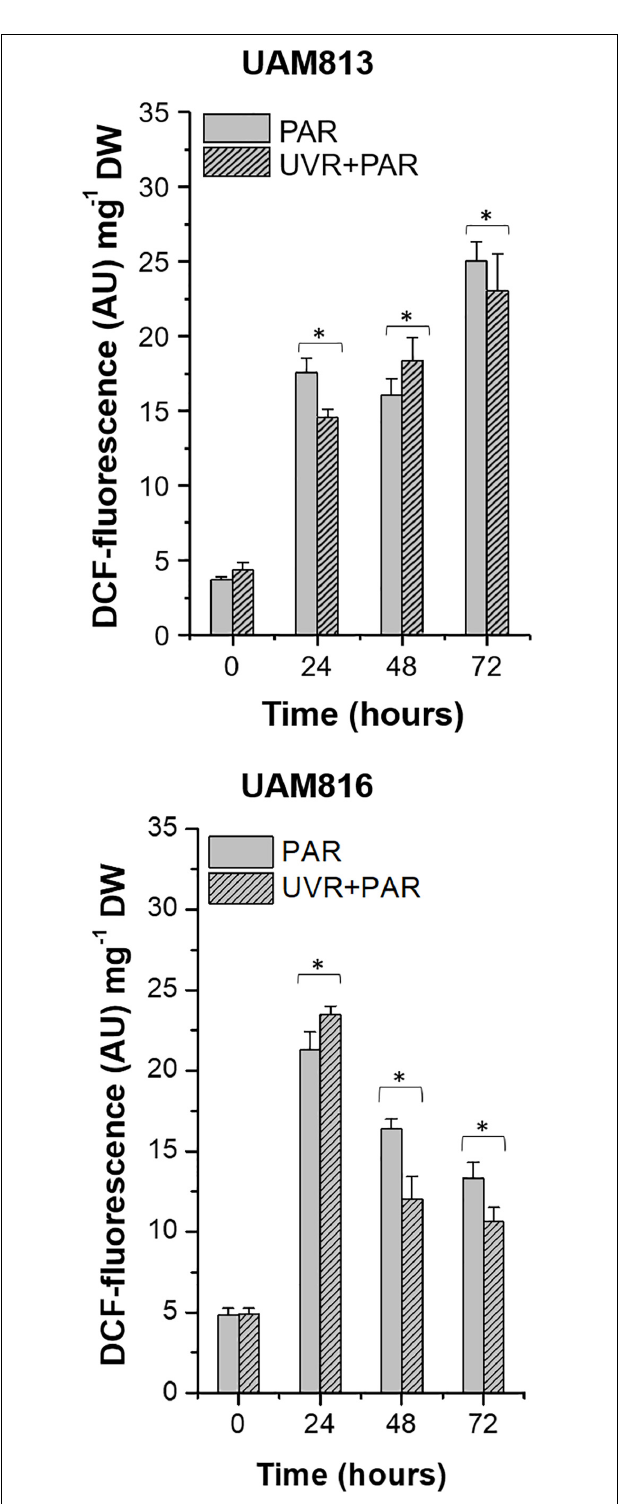
FIGURE 1 | DCF fluorescence in UAM813 (upper graph) and UAM816 (lower graph) cells after irradiation with PAR (plain bars) or UVR + PAR (lined bars) for 72 h normalized to DW. Error bars indicate standard deviation. The asterisks indicate significant differences between light conditions at each timepoint ( t -test p <